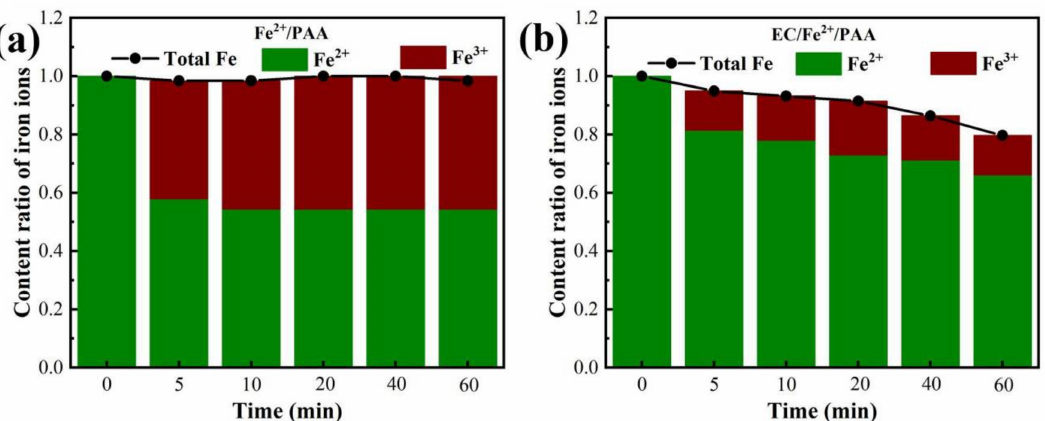
Figure 4. Changes in Fe content in Fe 2+ /PAA process ( a ) and EC/Fe 2+ /PAA ( b ). Experimental condi- tions: [MB] 0 = 20 mg L − 1 , [Fe 2+ ] 0 = 30 µ mol L − 1 , [PAA] 0 = 5.4 mmol L − 1 , [H 2 O 2 ] 0 = 11.25 mmol L − 1 , [NaNO 3 ] = 30 mmol L − 1 , pH = 2.9, j = 15 mA cm − 2